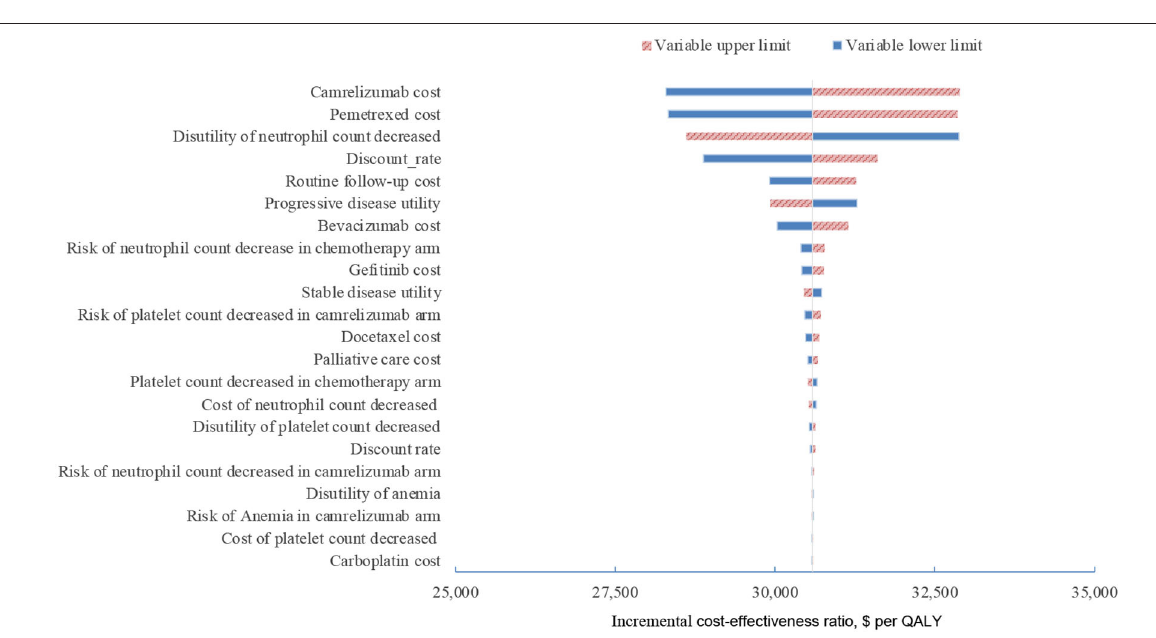
a high proportion of patients switching from chemotherapy to camrelizumab after progression in the CameL trial, in the context of the current reality that not yet approving second- line camrelizumab in China for advanced non-squamous NSCLC (23, 24). The crossover diluted the survival benefits